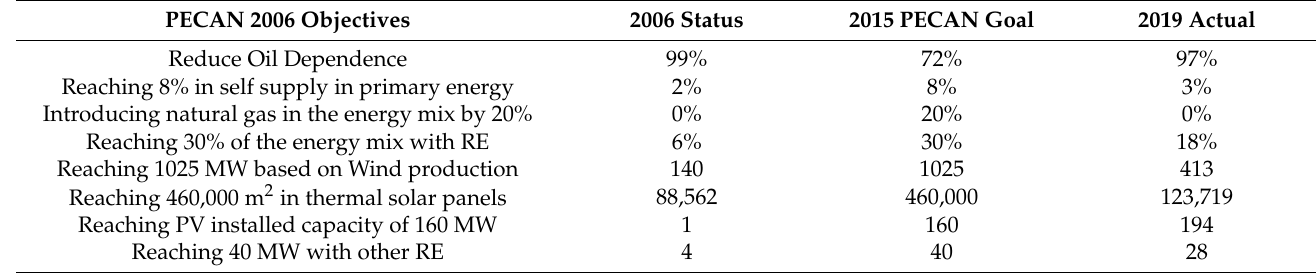
Table 1. Comparative: 2006 Initial Situation, Objectives Set by PECAN 2006 and 2019 situation. Own elaboration according to the energy yearbooks of the Canary Islands 2019 and PECAN 2006.